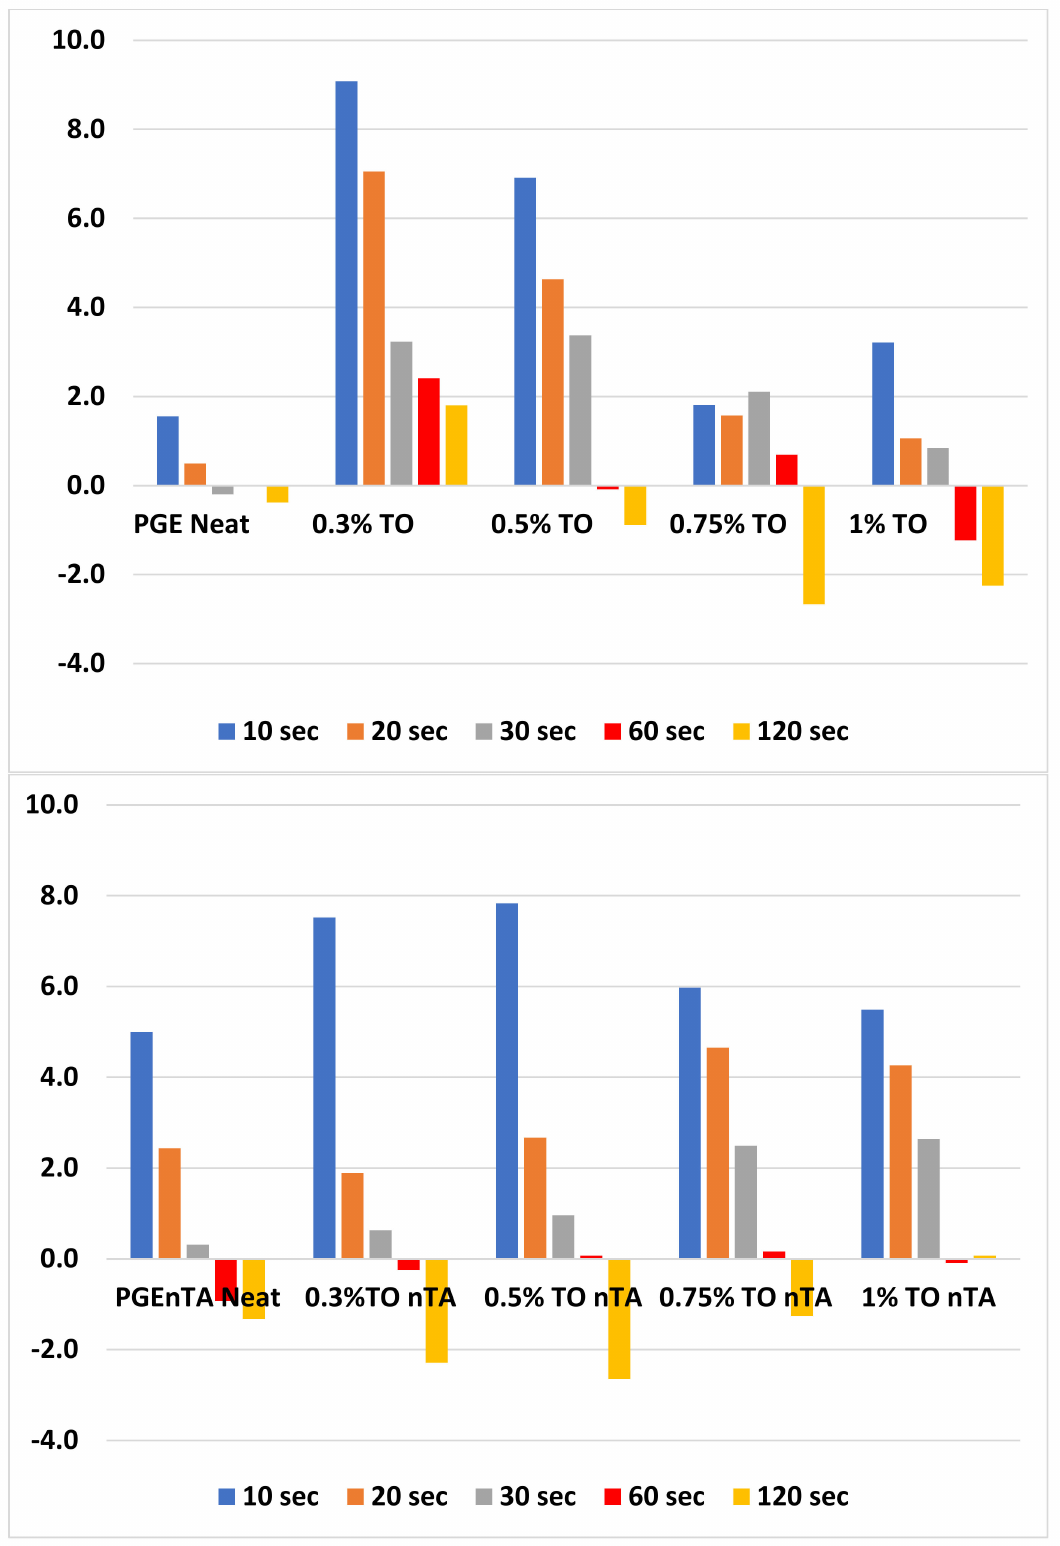
Figure 11. The differential DC between the near side and far side for PGE ( top ) and PGEnTA ( bottom ) with WS 2 -TO at various